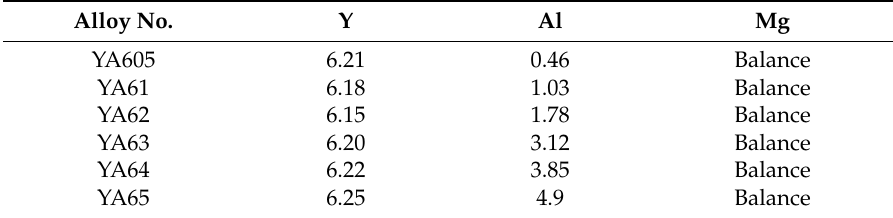
Table 1. Chemical compositions of the Mg-6Y- x Al alloys (wt